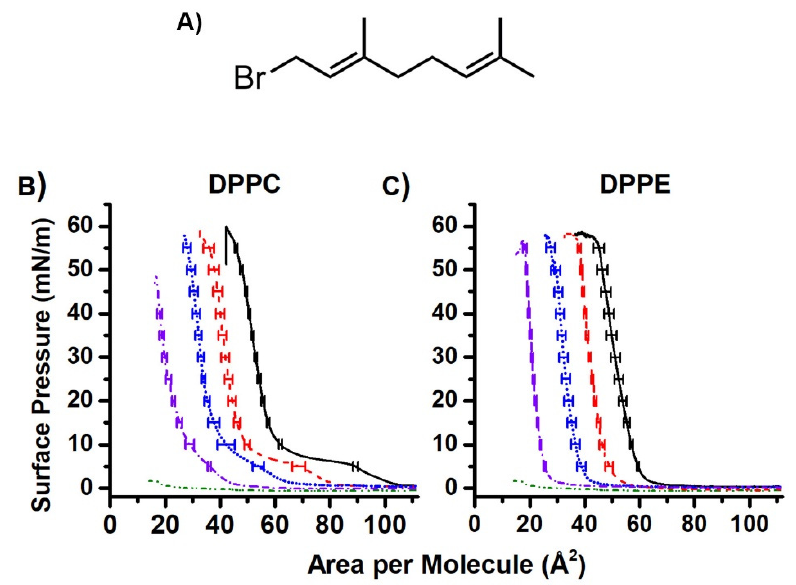
Figure 4. Compression isotherms of mixed films containing geranyl bromide. ( A ) The structure of geranyl bromide. ( B ) Compression isotherms of geranyl bromide and DPPC. ( C ) Compression isotherms of geranyl bromide with DPPE. Red dashed curves show 75:25 phospholipid:geranyl bromide films. Blue dotted curves are 50:50 phospholipid:geranyl bromide films. Purple dash-dot curves are 25:75 phospholipid:geranyl bromide films. Green dash-dot-dot curves are pure geranyl bromide films.